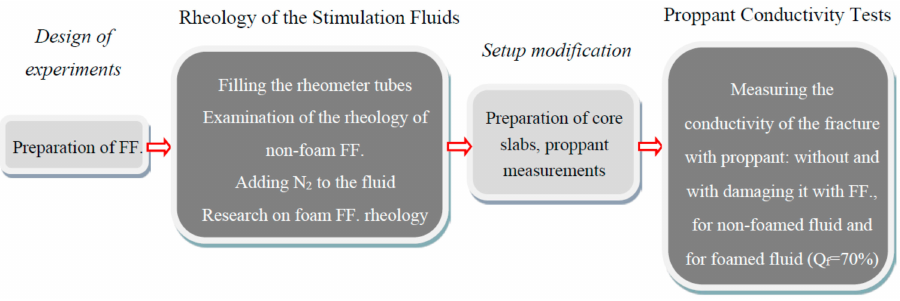
Figure 1. Flow chart diagram of the